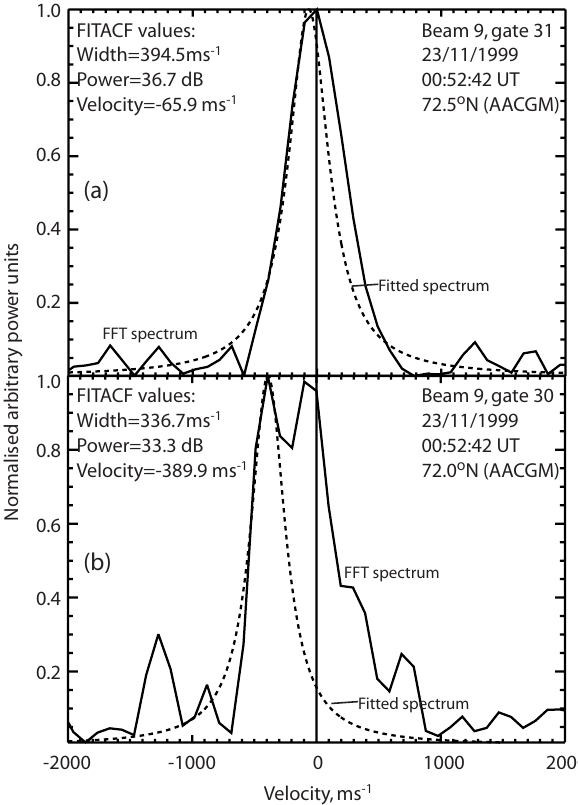
Fig. 9. Two typical normalised power spectra (FFT of ACF) from the high spectral width region observed by CUTLASS Fin- land on 23 November 1999. These spectra are from beam 9, (a) gate 31 ( ∼ 72.5 ◦ N AACGM), (b) gate 30 ( ∼ 72.0 ◦ N AACGM) at 00:52:42UT. Fitted spectra for the FITACF parameters (assuming an exponential ACF) are overlaid as dashed lines.